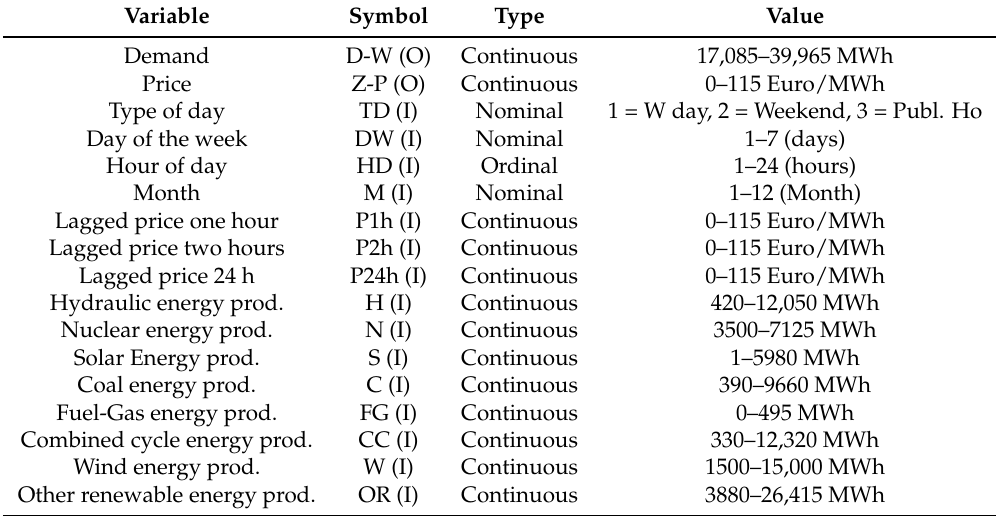
Table 5. Variables included in the data